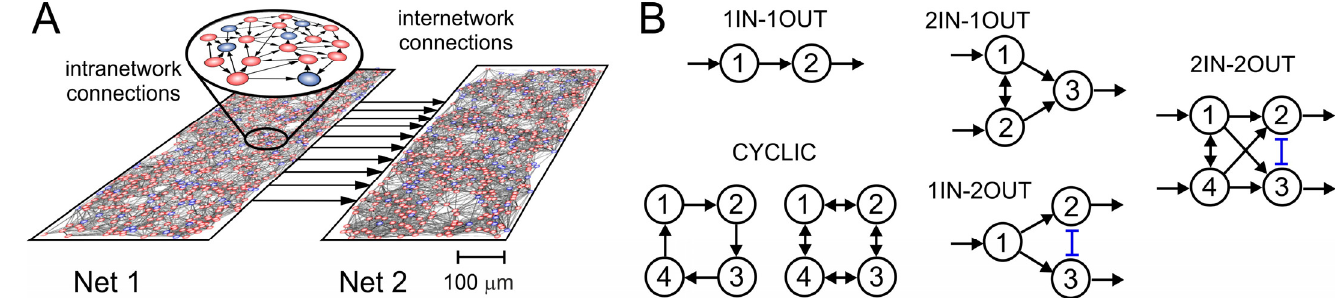
Figure 1. Model SNN architectures mimicking in vitro neuronal cultures coupled through microflu- idic channels in global circuits. ( A ) Local networks, each consisting of 500 neurons distributed over a rectangular substrate, are coupled using long-scale axons of projecting neurons in a global network structure. Within each network, neurons are linked by predominantly local couplings (red and blue circles correspond to excitatory and inhibitory neurons, respectively). ( B ) Global network architectures with a different number of inputs and outputs subject to Pavlovian learning studied in this work. Each circle corresponds to a local subnetwork (see Figure 1A). Arrowed links indicate the direction of internetwork couplings. Blue couplings are inhibitory.